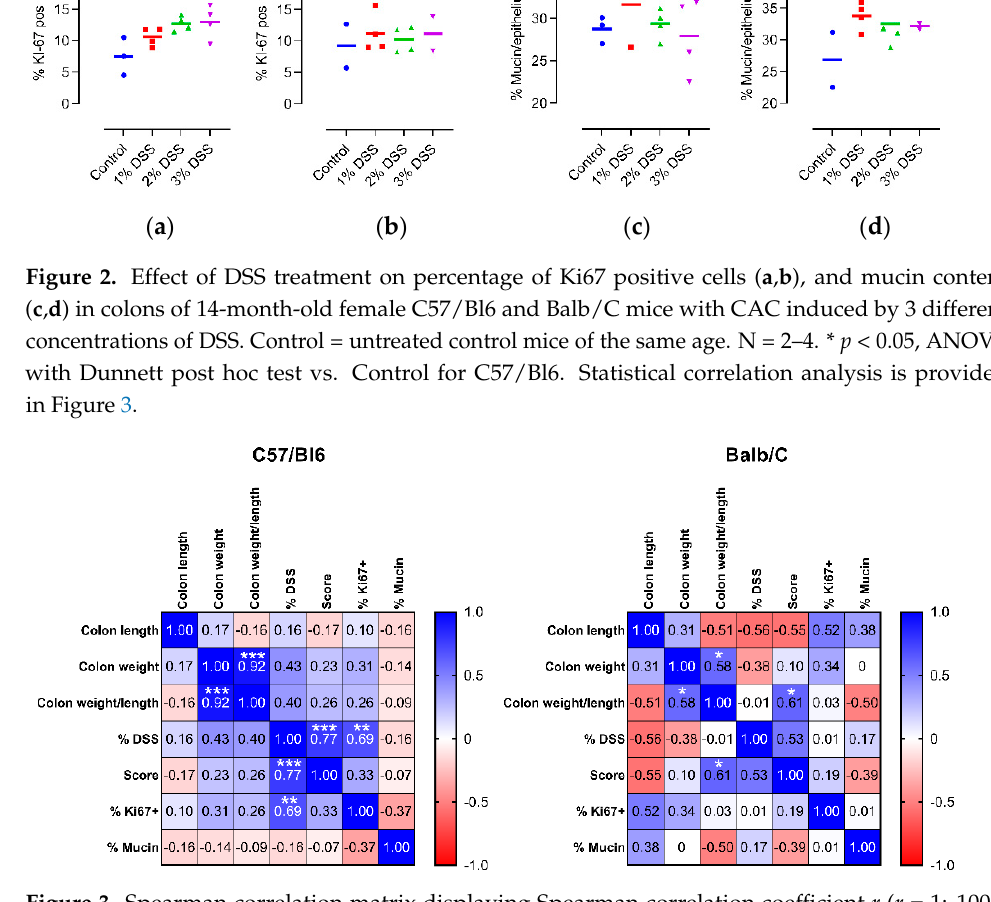
Figure 3. Spearman correlation matrix displaying Spearman correlation coefficient r ( r = 1: 100% positive correlation, r = 0: no correlation, r = − 1: 100% negative correlation) for all pairs of variables measured in C57/Bl6 ( n = 15) and Balb/C ( n = 12) mice (including non-treated control mice). Blue = positive correlation, white = no correlation, red = negative correlation. * p < 0.05, ** p < 0.01, *** p < 0.001 significance for correlation.